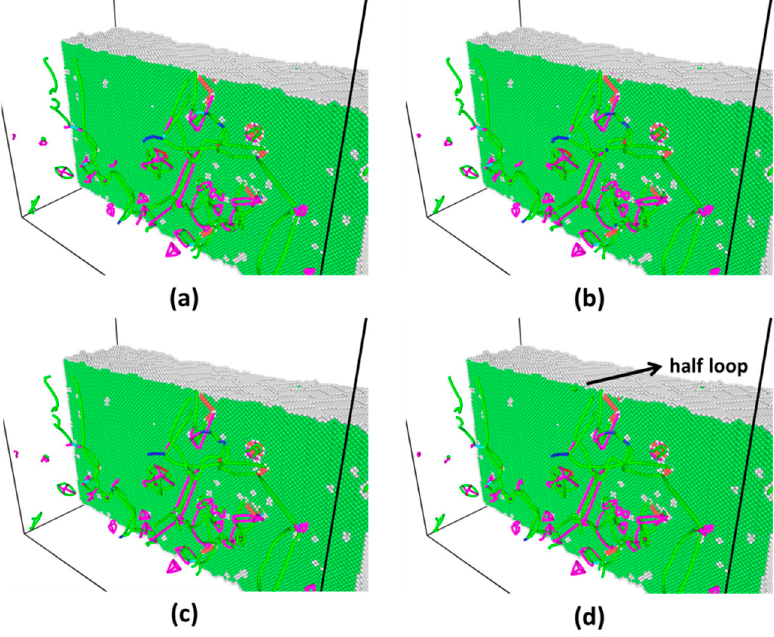
Figure 14. Snapshots of atomic structure and distributions of dislocations across the sample under strain 0.40. (a – d ) are corresponding to red circles marked in Figure 12b. ( d ) Shows a half loop nucleated under the tip.